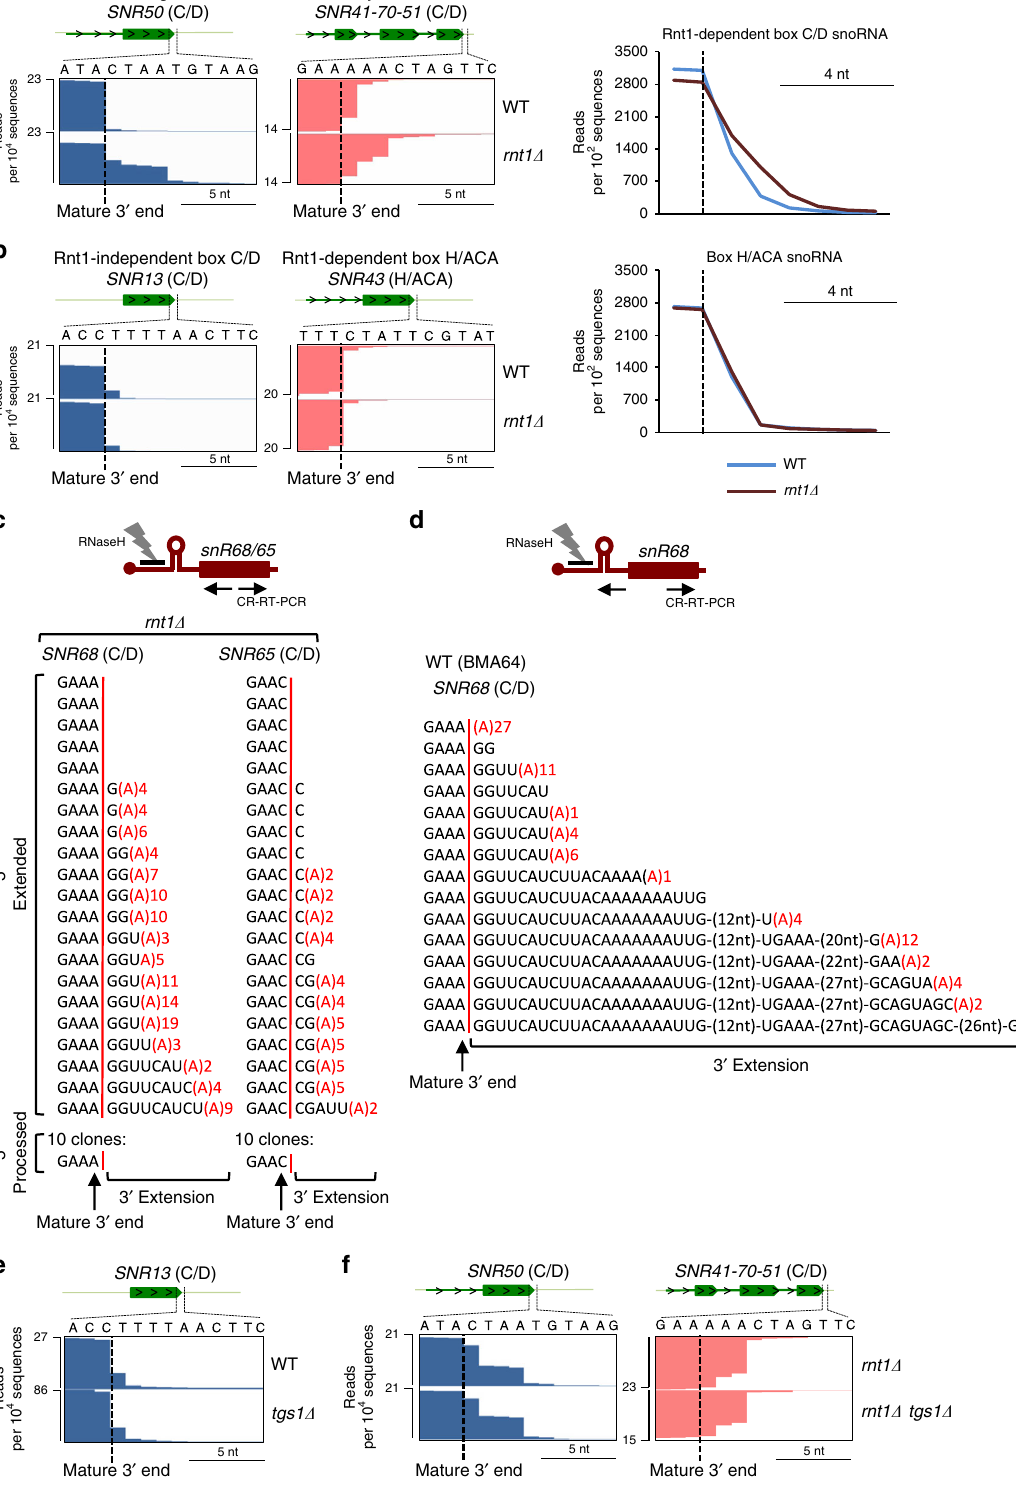
Fig. 3 Lack of the 5 ʹ processing affects box C/D snoRNA 3 ʹ end maturation. RNA-seq analysis of a RD box C/D snoRNA and b Rnt1-independent box C/D snR13 as well as RD box H/ACA snoRNA 3 ʹ ends in WT versus rnt1 Δ strains. Metagene analyses are shown on the right. Dotted vertical lines denote mature 3 ʹ end. c , d CR-RT-PCR analysis as shown in diagram, for snR68 and snR65 in rnt1 Δ and WT strain. Red vertical lines separate mature 3 ʹ ends from 3 ʹ extension (post-transcriptionally added oligo(A) in red). e , f RNA-seq analysis of speci fi ed snoRNA 3 ʹ ends in tgs1 Δ and rnt1 Δ /tgs1 Δ strains. SnoRNA used for metagene analysis are listed in Supplementary Table